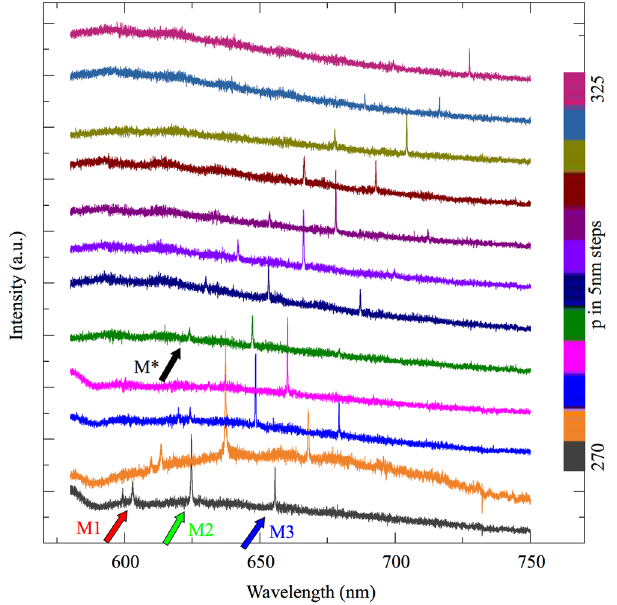
Figure 3. Geometric tuning. Spectra of PCCs with periods from 270 nm (bottom) to 325 nm (top). The red (green, blue) arrow marks the M1 (M2, M3) mode. The resonance wavelengths increase linearly with the period. PCCs with p ≥ 290 nm show an additional mode M * (marked by the black